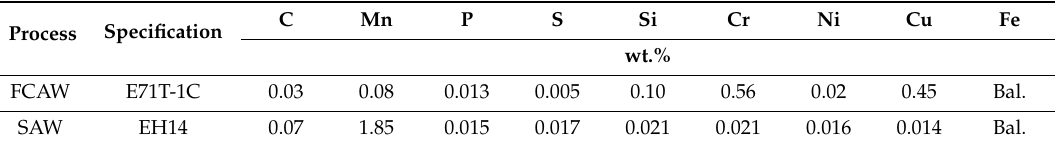
Table 3. Chemical composition of the filler